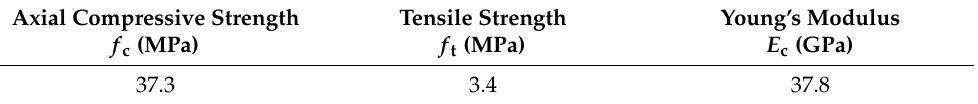
Table 2. Mechanical properties of